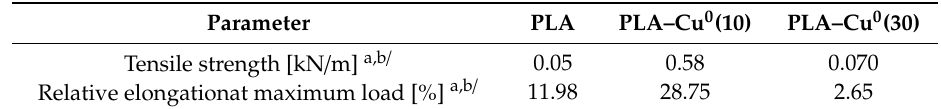
Table 7. Results of tensile strength test of PLA and hybrids PLA–Cu 0 (t), according to: EN